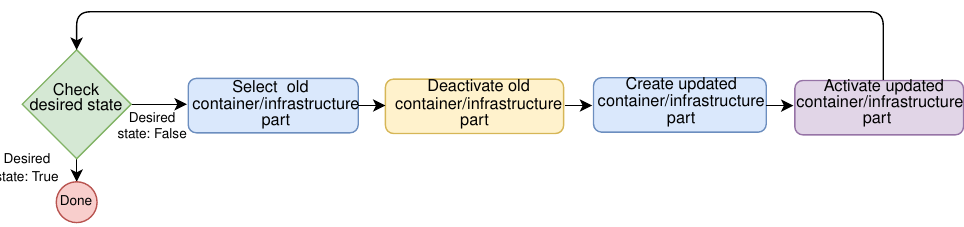
Figure 11. Rolling update flow chart.